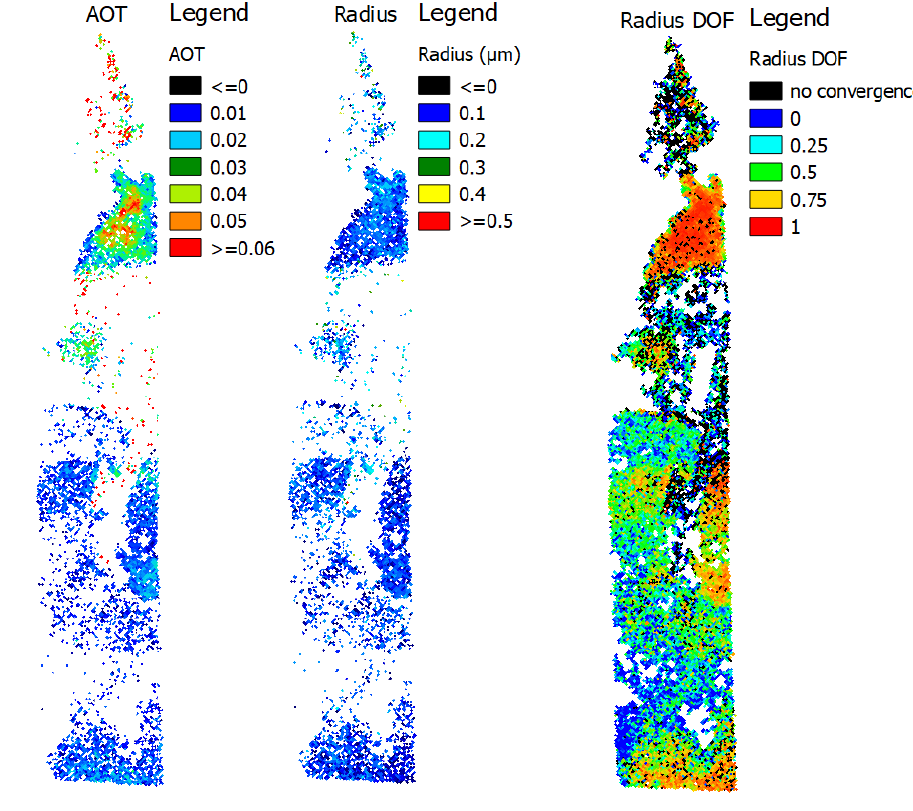
( a ) AOT (left image) and modal radius maps (right image) Figure 8. OEM-retrieved: ( a ) AOT and modal radius; and ( b ) radius DOF map.